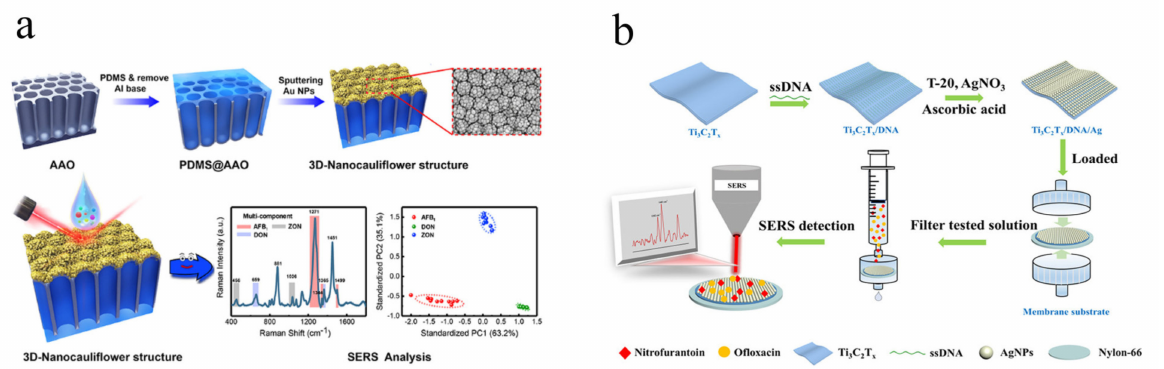
Figure 6. Schematic fabrication of cauliflower-inspired chip-based SERS substrate for simultaneous label-free analysis of multiple mycotoxins ( a ). © 2022 American Chemical Society. Adapted with permission from [33]. Schematic preparation process of the Ti 3 C 2 T x /DNA/Ag membrane substrate and its application of simultaneous and accurate quantification of multiple antibiotics ( b ). © 2022 American Chemical Society. Adapted with permission from